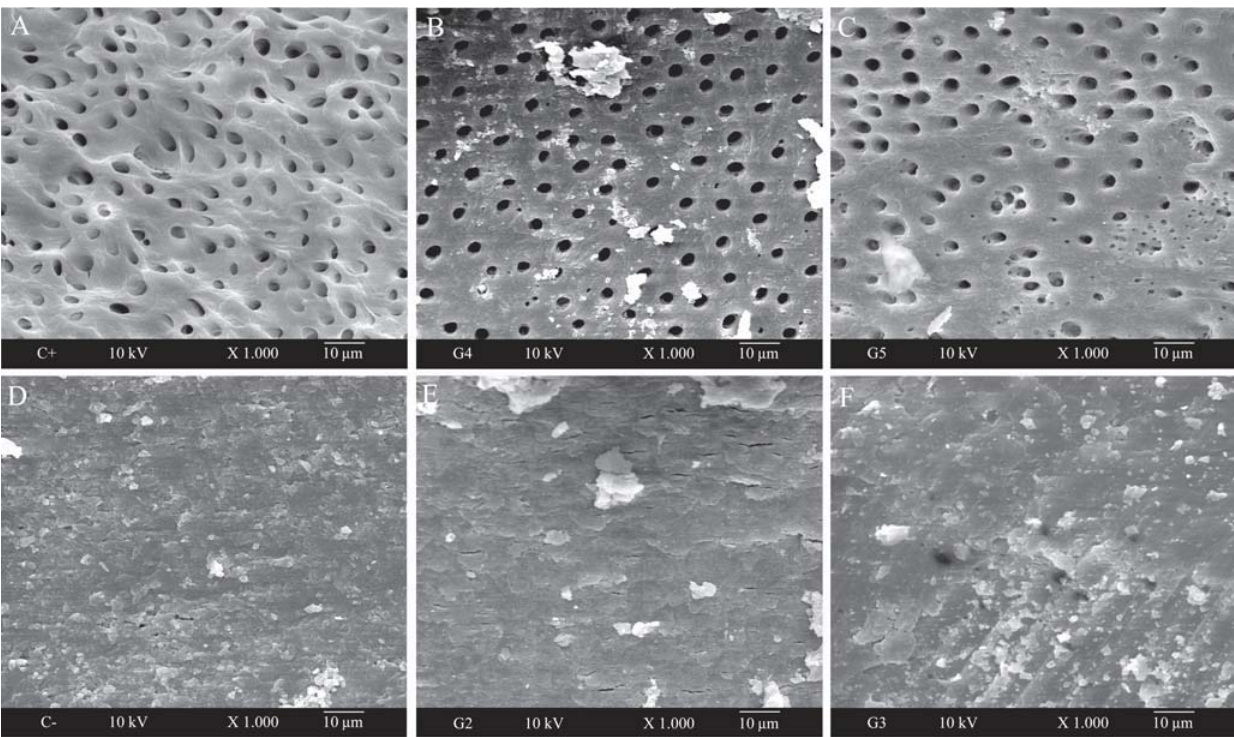
FIGURE 1- SEM micrographs of the groups. (A) Positive control group showing canal walls totally free of debris or smear layer, all tubules opened. (B-C) Typical thin smear layer and little amount of debris, with open dentinal tubules. (D) Negative control group showing canal walls covered by smear layer and debris with no open tubules. (E-F) Heavy smear layer and debris covering the dentinal walls, with a small number of open dentinal tubules